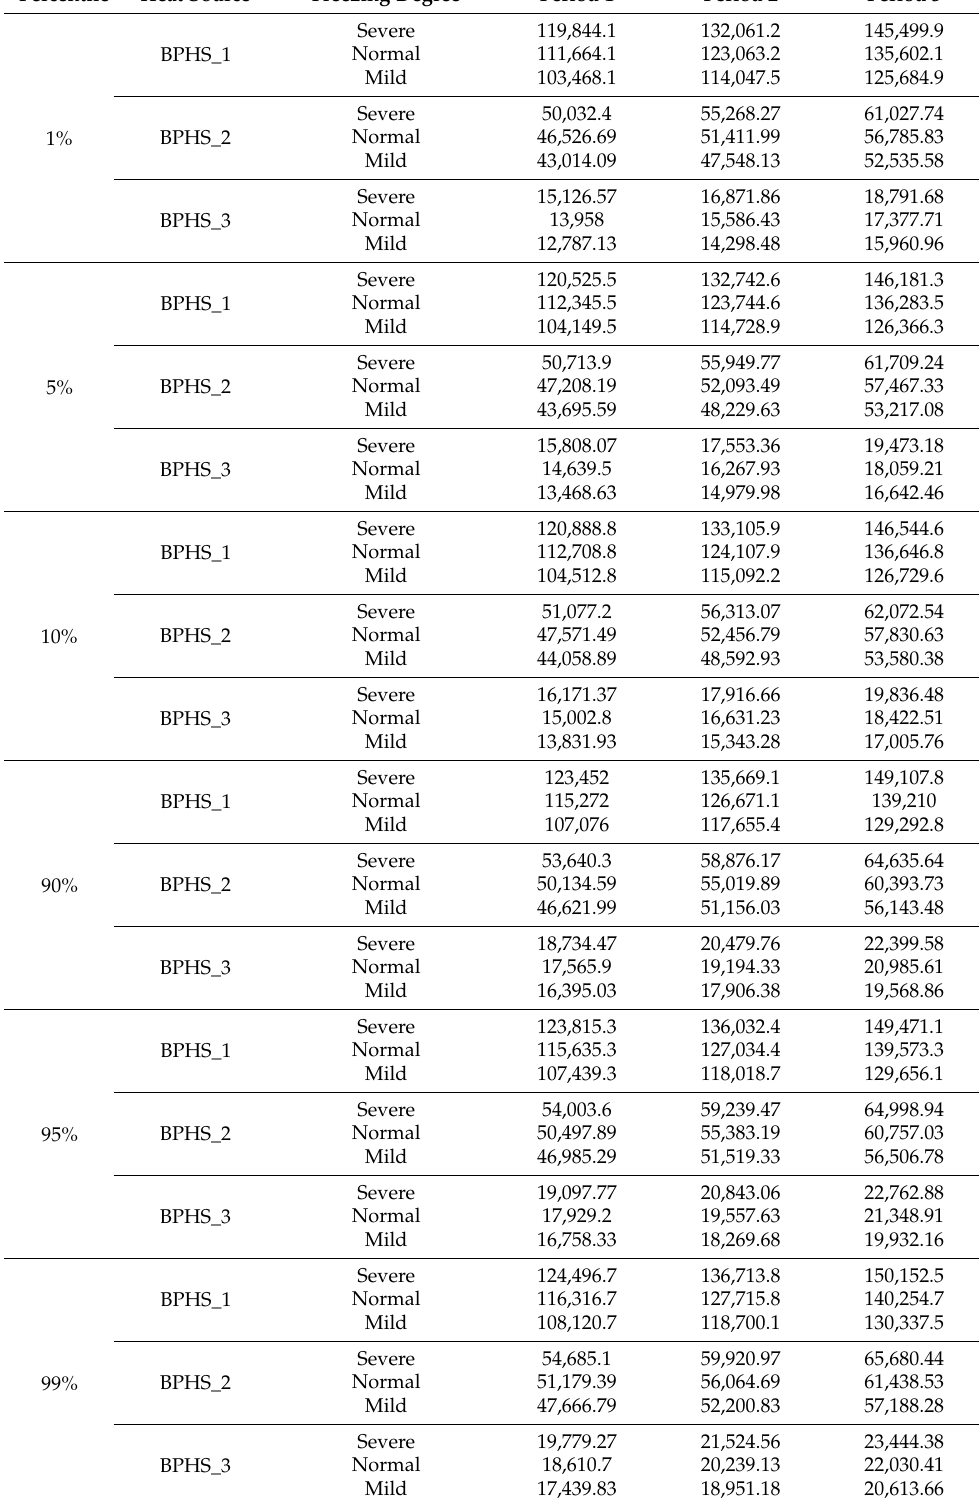
Table A2. Heat provisions undertaken by different peak-shaving heating sources under α = 0.55,